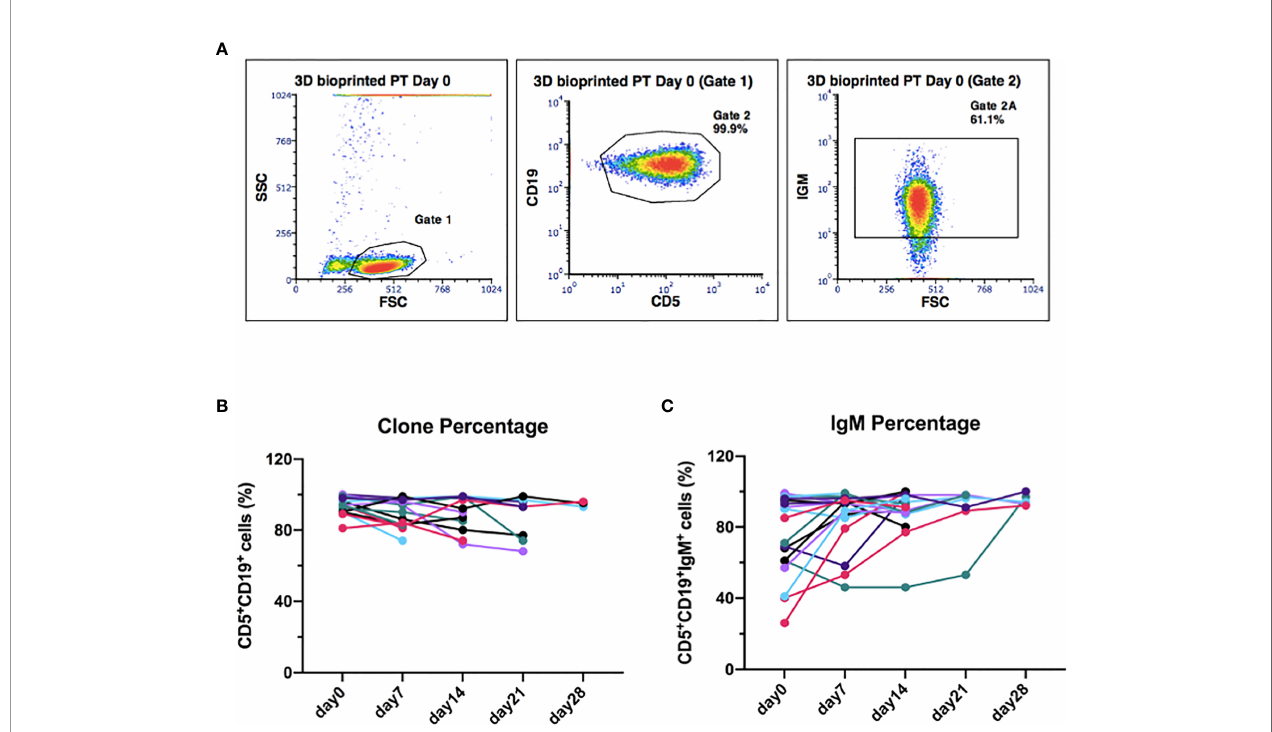
FIGURE 7 | The original CLL clone phenotype CD19/CD5 is maintained throughout the 3D culture, including the levels of IgM. (A) Representative fl ow cytometry plots of 3D-bioprinted CLL primary cells (day 0) showing the presence of the leukemic clone and the surface marker IgM, based on the expression of CD19/CD5 and IgM surface markers. Physical parameters of 3D bioprinted hydrogel alone are shown as well. (B) The graph shows the leukemic clone percentage of all samples analyzed overtime (n = 15). (C) The graph shows IgM surface marker percentage of all samples analyzed overtime (n =